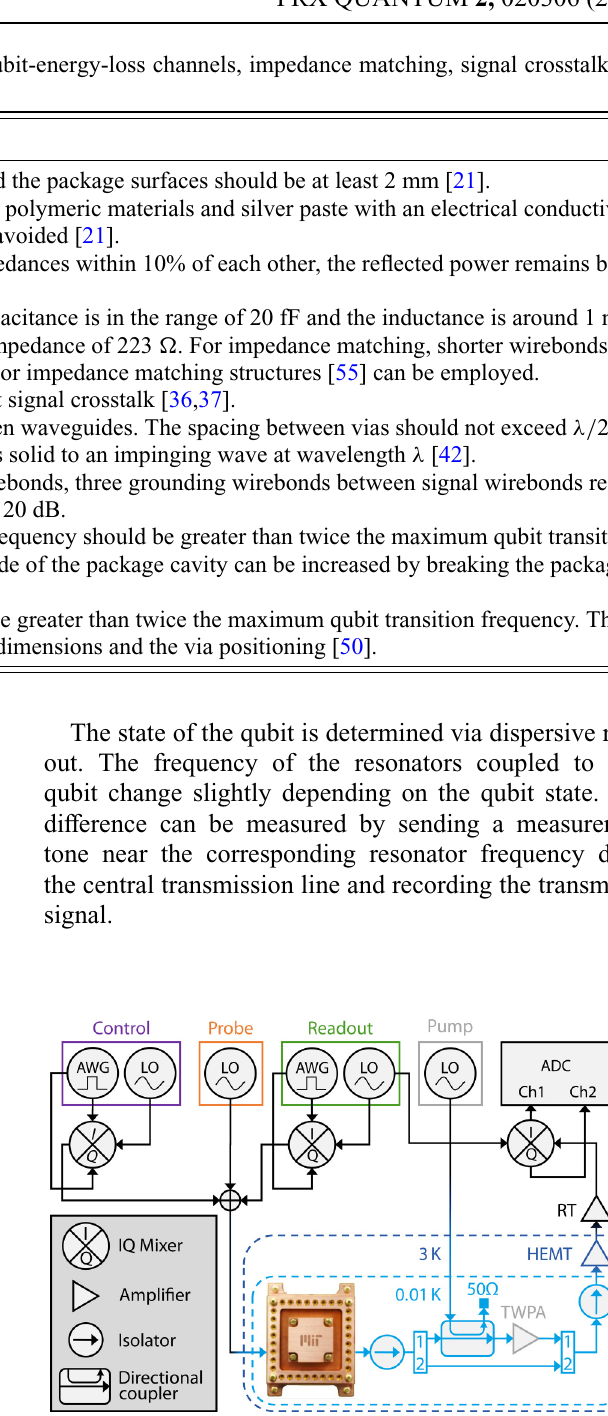
FIG. 8. Measurement setup used to obtain the mode profile of the package. The control, readout, and probe signals are com- bined and sent down the dilution refrigerator with a total of 60 dB of attenuation distributed at various stages (not